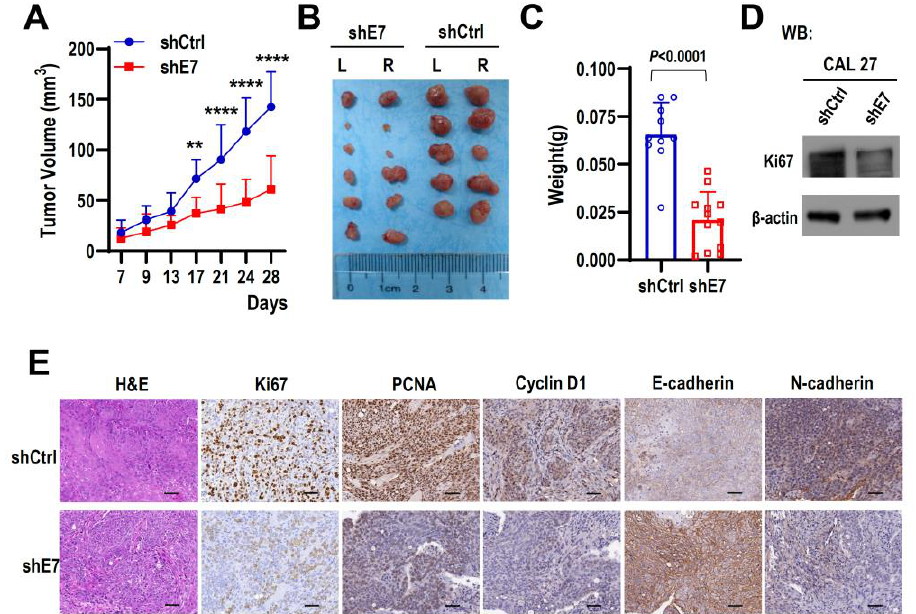
Figure 3. Ki67 exon 7 is essential for tumorigenicity of HNSCC cells in vivo. ( A ) CAL 27 cells with stable shE7 or shCtrl expression were injected into both sides of the flank region of BALB/c nude mice. Tumor volumes were measured on the indicated days. ** p < 0.01, **** p < 0.0001. Data are mean ± SD, n (shE7) = 6, n (shCtrl) = 5. ( B , C ) Tumors were dissected out and weighed on Day 28. The boxplot represents the tumor weight in two groups of mice on Day 28. ( D ) The total protein samples of cells were collected at the injection time. Western blot displayed the knockdown efficiency of Ki67 protein, β -actin served as a loading control. ( E ) Representative images of HE and immunohistochemical staining of Ki67, PCNA, cyclin D1, E-cadherin, and N-cadherin in tumors dissected from nude mice. The scale bar represents 50 µ